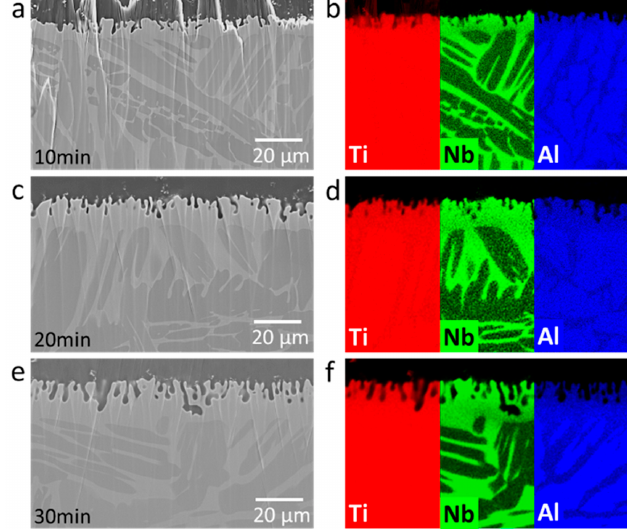
Figure 2. Scanning electron micrographs and corresponding element maps of an ion-milled cross section of Ti-6Al-7Nb dealloyed in liquid Mg at 1150 K for different times: ( a , b ) 10 min, ( c , d ) 20 min, and ( e , f ) 30 min.